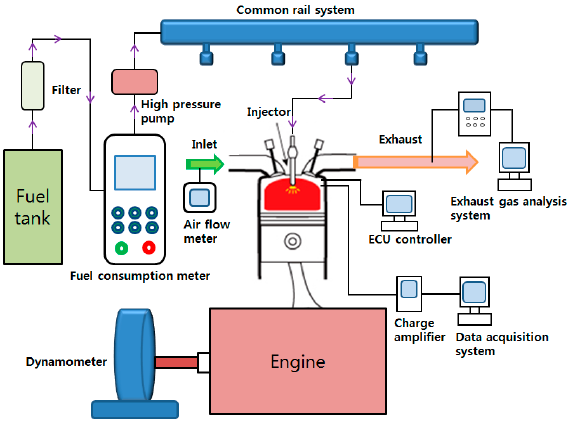
Figure 9. Schematic diagram of common experimental apparatus.